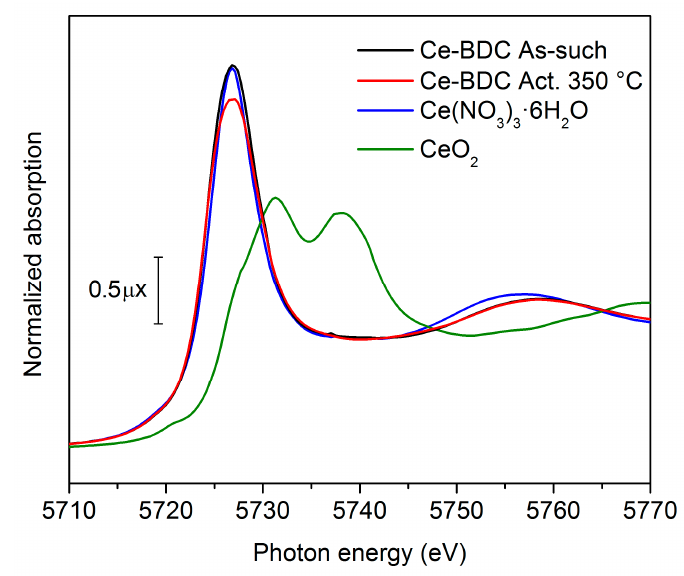
Figure 3. Ce L 3 edge XANES spectra of Ce 5 (BDC) 7.5 (DMF) 4 as synthesized and activated at 350 °C, compared with CeO 2 and Ce(NO 3 ) 3 · 6H 2 O.